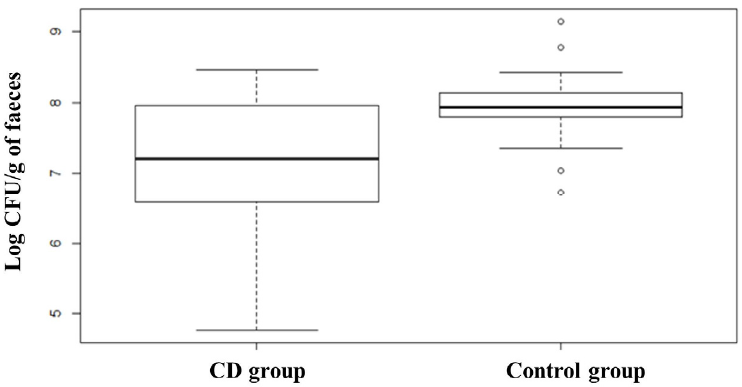
Figure 8. Box plots showing qPCR analysis of Lactobacillus group expressed in log CFU per gram of faecal sample relative to CD group and Control group. CD group is composed of Probiotic T0, Placebo T0 and Placebo T1 samples. Statistical difference between the two groups ( p ‐ values of < 0.01).